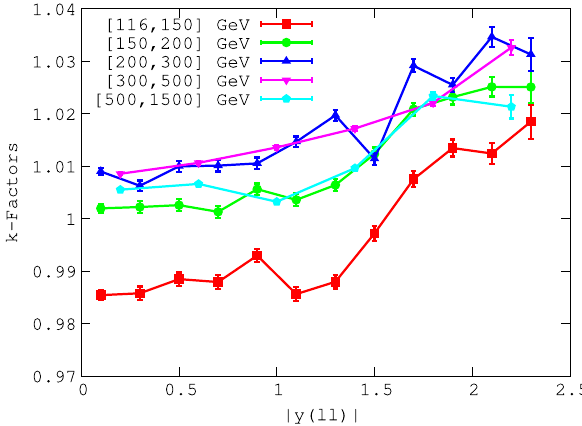
Fig. 2 The NNLO/NLO K -factors, defined in Eq. (1), which account for higher-order QCD and EW effects to the high-mass Drell–Yan cross sections with the photon-induced contribution subtracted, as a function ofthedileptonrapidity | y ll | .Eachsetofpointscorrespondstoadifferent bin in the dilepton invariant mass m